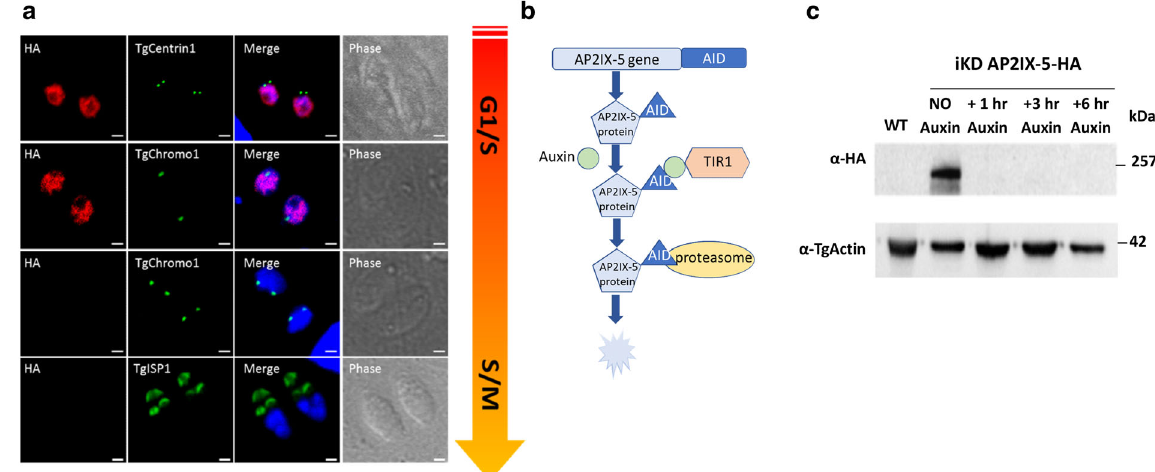
Fig. 1 TgAP2IX-5 is a cell-cycle-regulated protein. a Confocal imaging demonstrating the expression of the TgAP2IX-5 protein using anti-HA antibody during the tachyzoite cell cycle. Anti-TgCentrin1, anti-TgChromo1, and anti-TgISP1 were used as cell cycle markers. The schematic cell cycle phase is indicated on the right side of the fi gure and the scale bar (1 µ m) is indicated on the lower right side of each confocal image. b Schematic representation of the AID system used to degrade the TgAP2IX-5 protein. This system consists of introducing a recognition sequence into the gene of interest, which expresses a protein fused to the recognition sequence and in the presence of Auxin, will be recognized by the TIR1 protein and degraded by the proteasome. This system was used to produce an inducible knockdown parasite in which the expression of TgAP2IX-5 can be controlled. c Western blot of total protein extract from the parental and iKD TgAP2IX-5 strains treated with Auxin for different durations of time validating the AID system. Western blots were probed with anti-HA to detect the presence of TgAP2IX-5 protein (upper panel), anti-TgActin was used as a control for normalization (lower